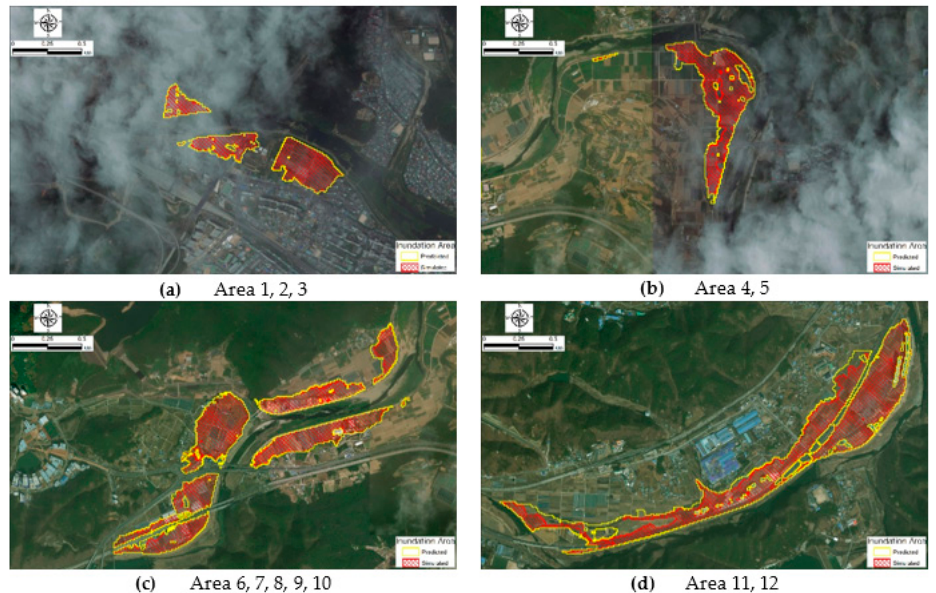
Figure 15. Comparison of inundation area (Typhoon Chaba).